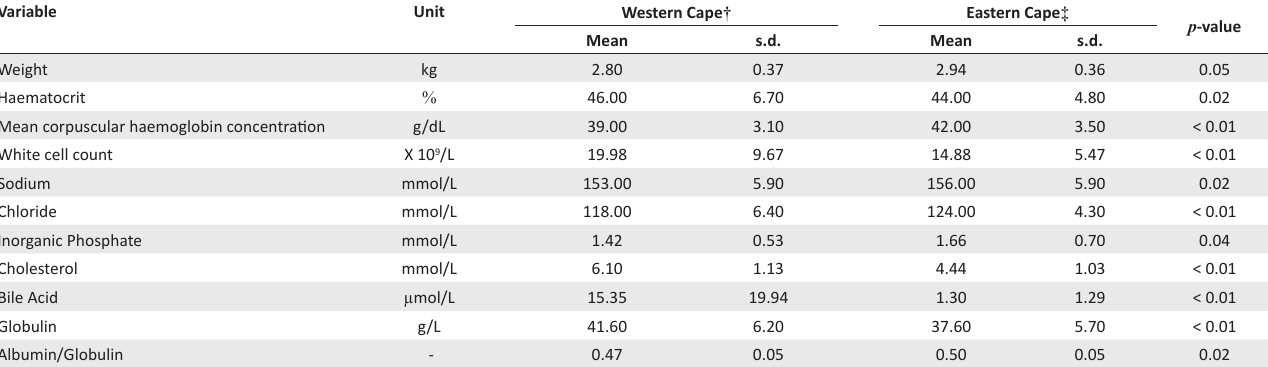
TABLE 3: Mean and standard deviations for all haematology and blood chemistry values that were significantly different by region for African penguins sampled, using an independent sample t -test.